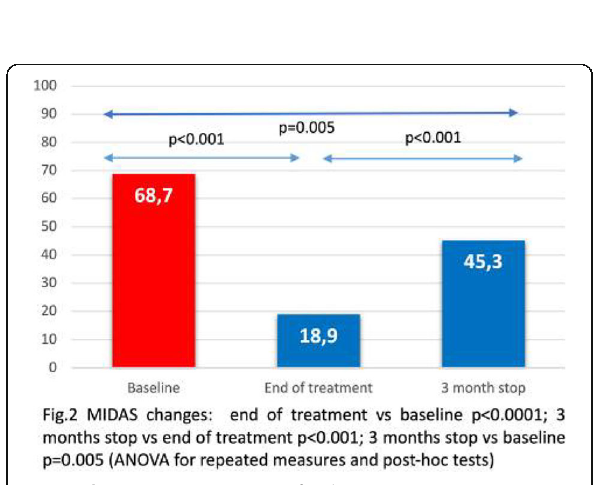
Fig. 2 (abstract P0302). See text for